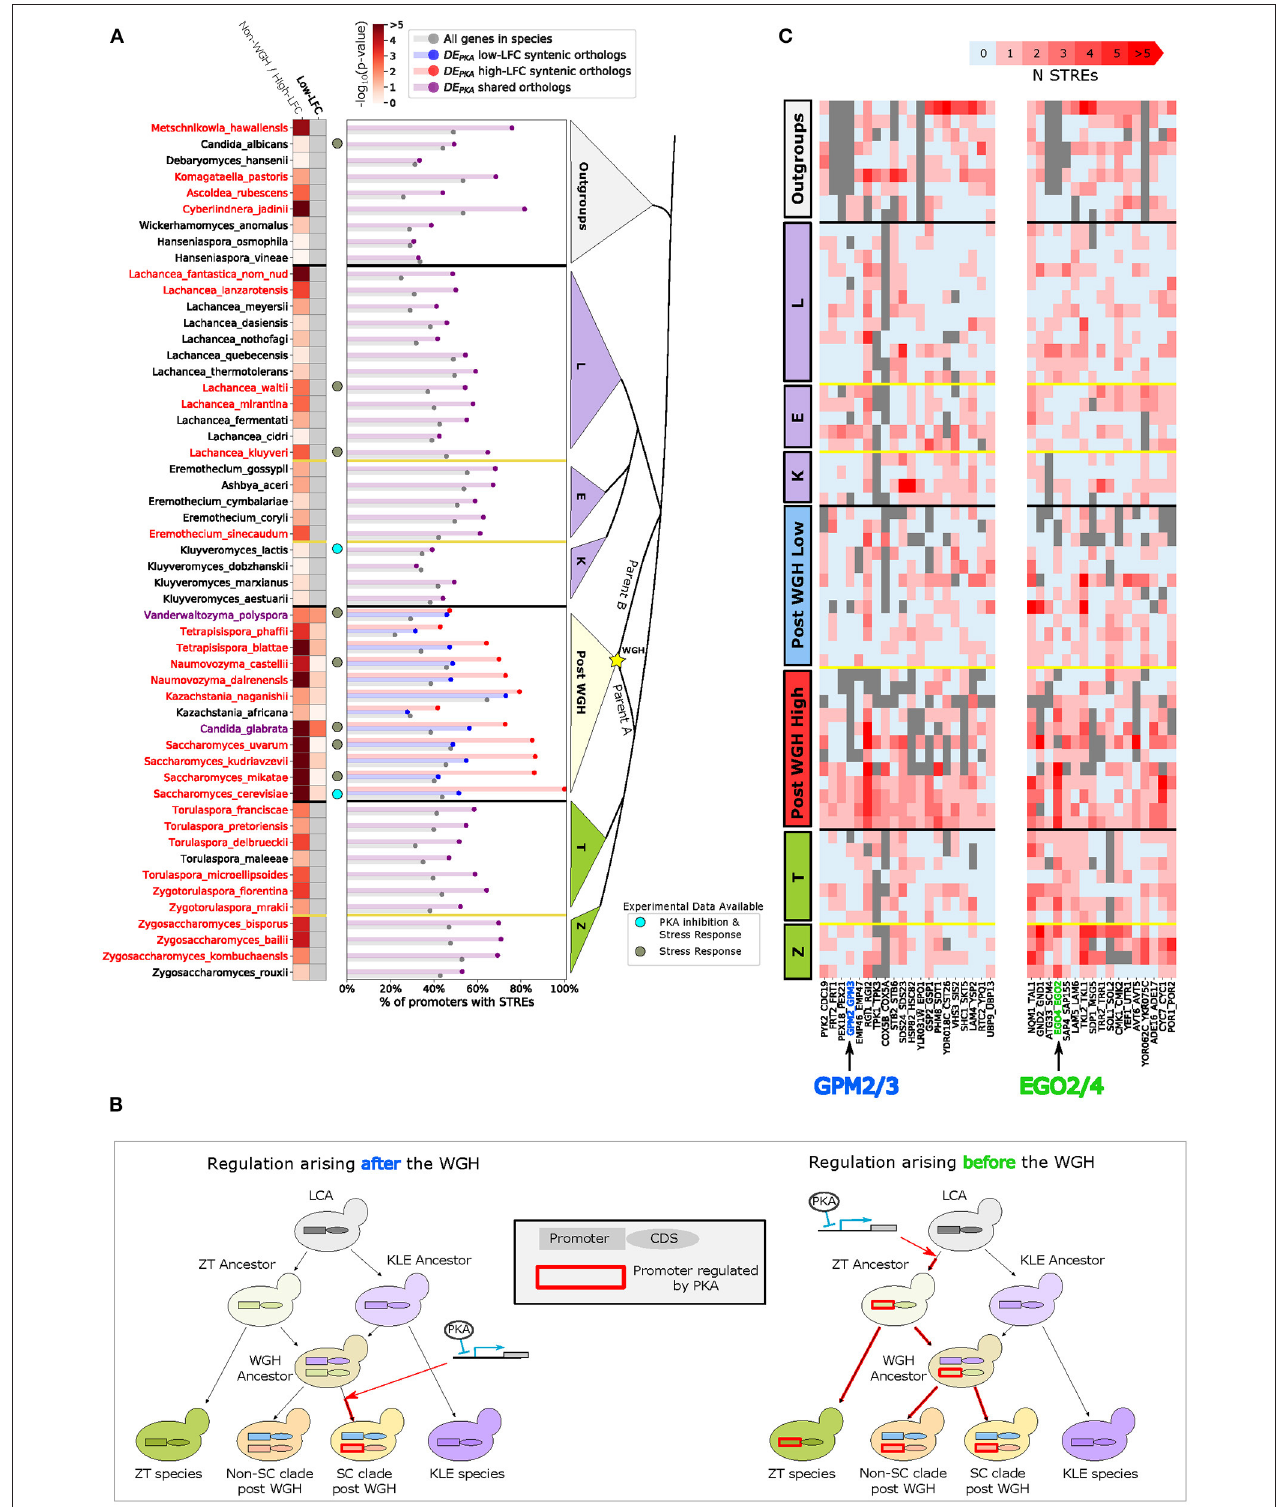
FIGURE 5 | There is enrichment for STREs in the promoters of the syntenic orthologs of the DE PKA high-LFC orthologs, as well as in the ZT branch, indicating that STREs arose in the promoters of DE PKA high-LFC orthologs both after and prior to the WGH. (A) The barplot shows the percentage of promoters with 1 or more